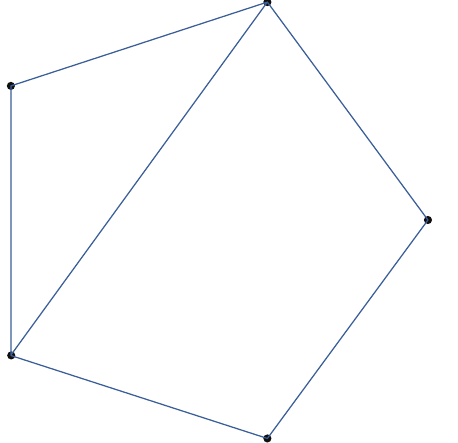
Figure 1: The structure of complex networks with 𝑁 = 5 (Example 10).